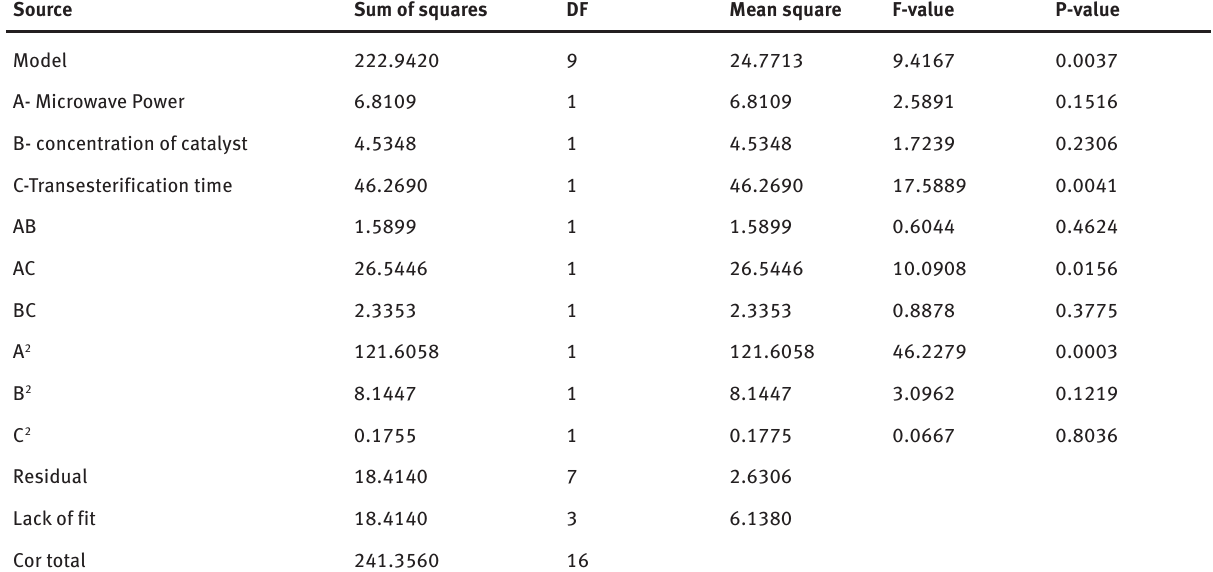
Table 3: ANOVA of quadratic equation model for response